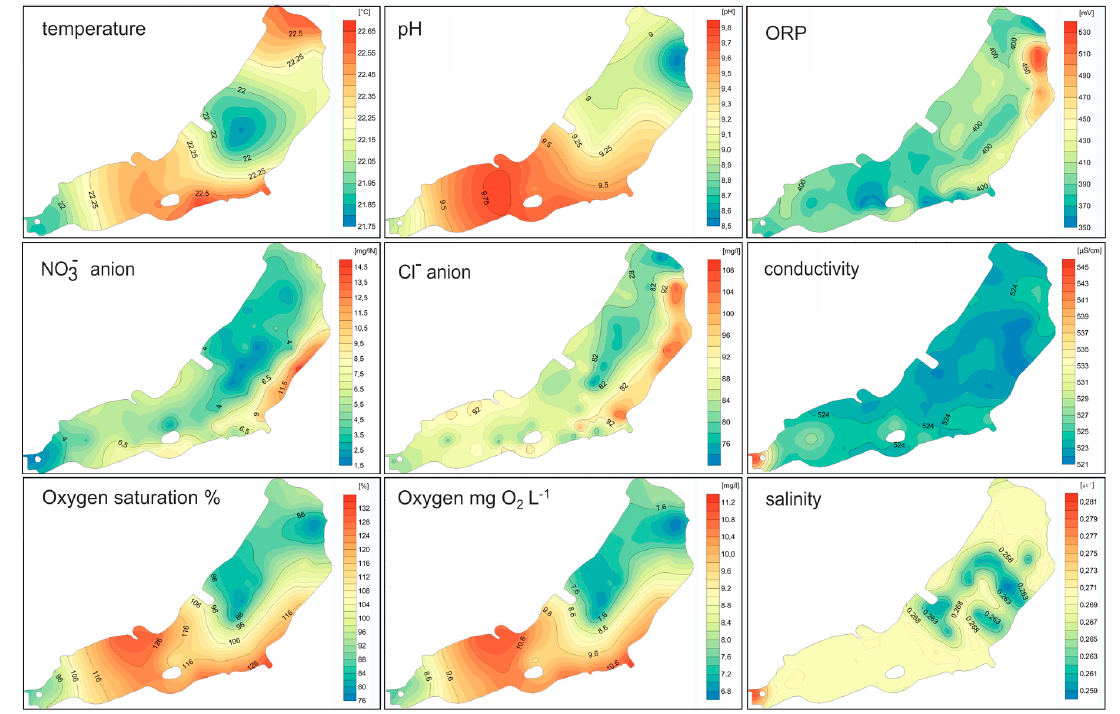
Figure 7. Spatial variability of physicochemical properties of the Paprocany reservoir water.